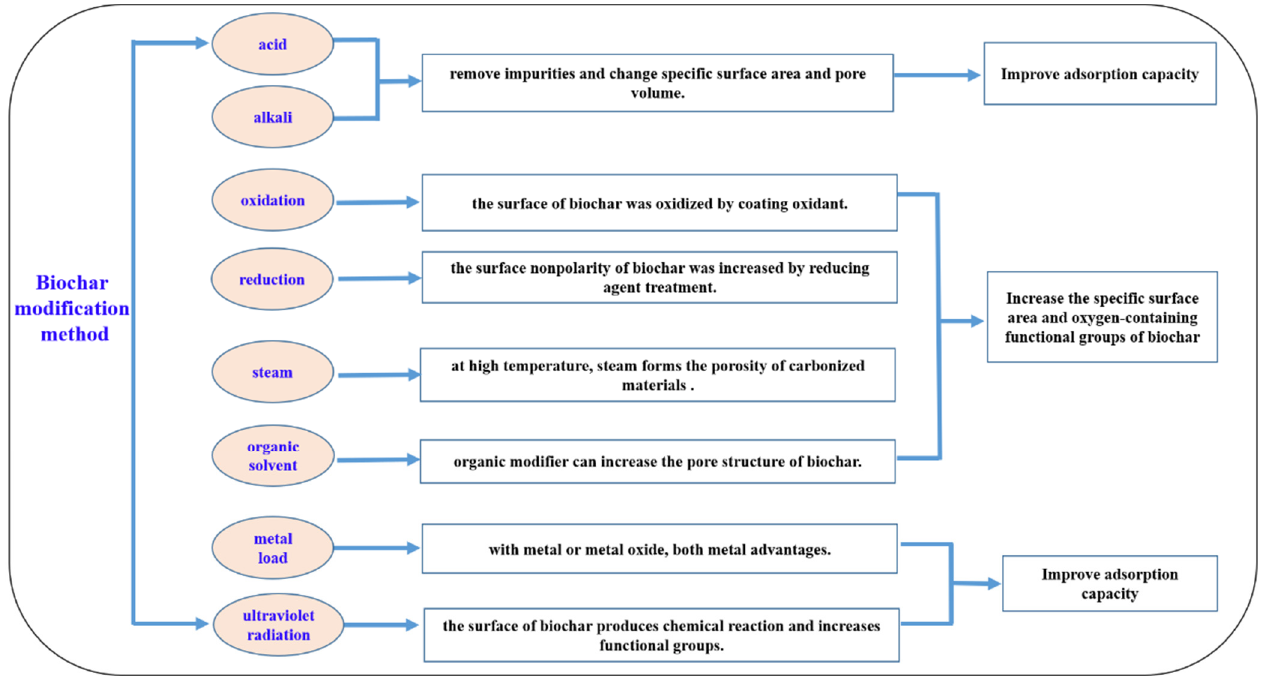
Figure 2. Common modification methods of biochar.